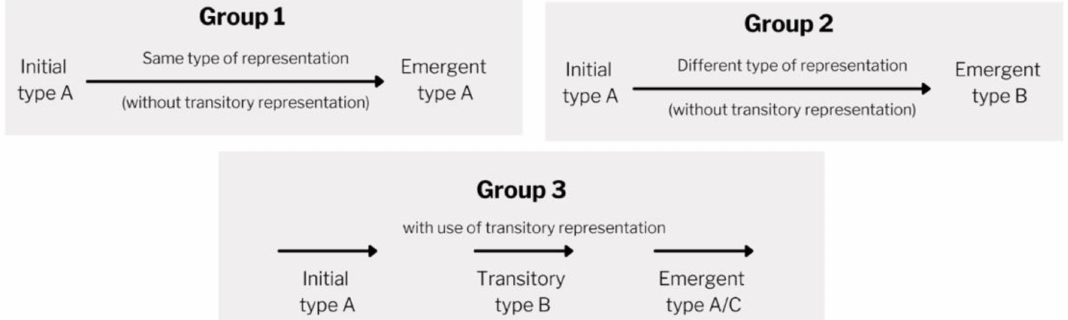
Figure 10. Task groups in relation to the transit of representations (Source: Prepared by the authors).